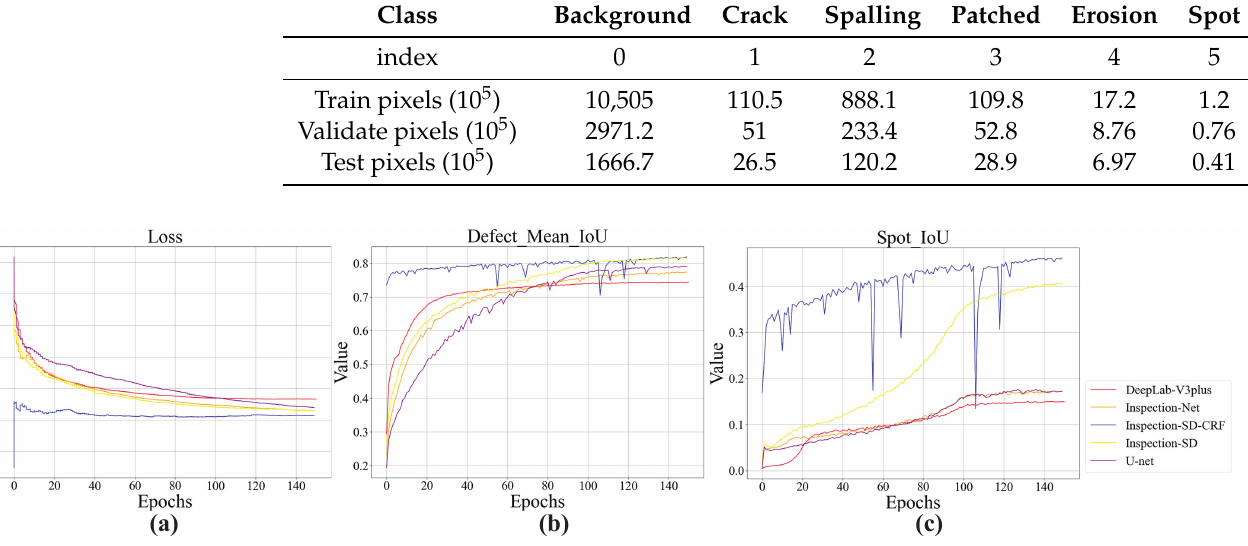
Figure 8. Training result comparison of different models. ( a ) The training Lovasz loss value (directly related to IoU), ( b ) defect mIoU, and ( c ) spot IoU changes during training are compared. On the test set, the results are compared in Table 2, including IoU, mIoU (mean IoU), and defect mIoU (except rope class). The mIoU is the average of all classes IoU, and defect mIoU is the average of all defect classes IoU. The model size column describes the total storage of model parameters. We divide the comparison models into two parts, the bottom two models are PSPNet and its variants using our CRF layers both have two times parameters. It can be seen from the results, that our model segmentation mIoU (second best mIoU and defect mIoU) is very close to the PSPNet and its variants, and has better segmentation of irregular defect erosion and small defect spot ability. It is weaker than PSPNet and DeeplabV3 plus in the segmentation of large defects. Compared with the number of parameters of the same level, our model has the best segmentation mIoU. Our Inspectio-n-SD–CRF model uses the smaller model to obtain better segmentation result on spot, mIoU, and defect mIoU, and also makes a big improvement for baseline Inspection- Net. As a method of side-out fusion results, U2Net can show the importance of the PAC layer in the comparison process with our model. DeeplabV3 plus and PSPNet use atrous separable convolution and pyramid parsing structures to learn multi-scale features and can also be compared with our model horizontally. These two networks have achieved higher accuracy for segmenting large-scale defects on our dataset through their respective multi- scale learning methods. Still, the segmentation results for irregular and small defects such as erosion and spot have not been better than the Inspection-SD-CRF network structure with fewer parameters. This is because PAC has better spatial adaptability to irregular patterns, and the U-Net structure combined with CRF is more suitable for extracting and learning small